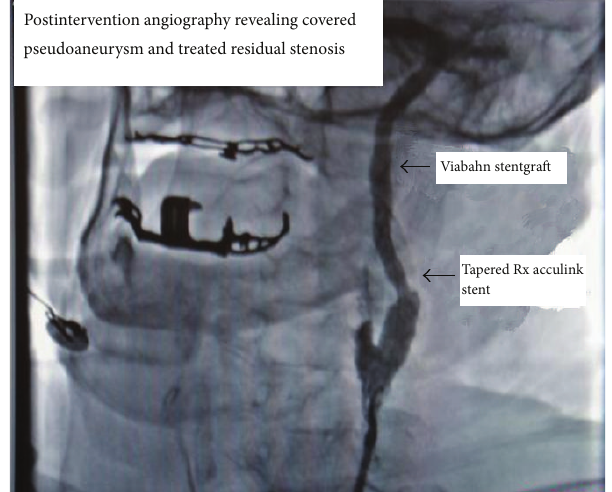
Figure 1: Computed tomography angiography of left internal carotid artery; pseudoaneurysm location is confirmed.